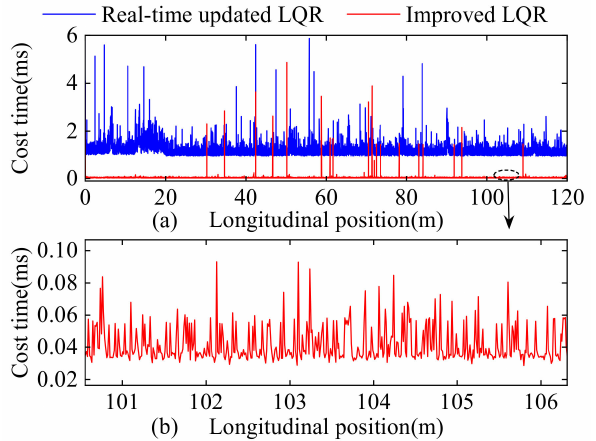
Figure 26. Comparison of the cost time between the improved LQR and the real-time updated LQR. ( a ) Cost time comparison overview of the two controllers. ( b ) Specific details of improved LQR controller cost time.